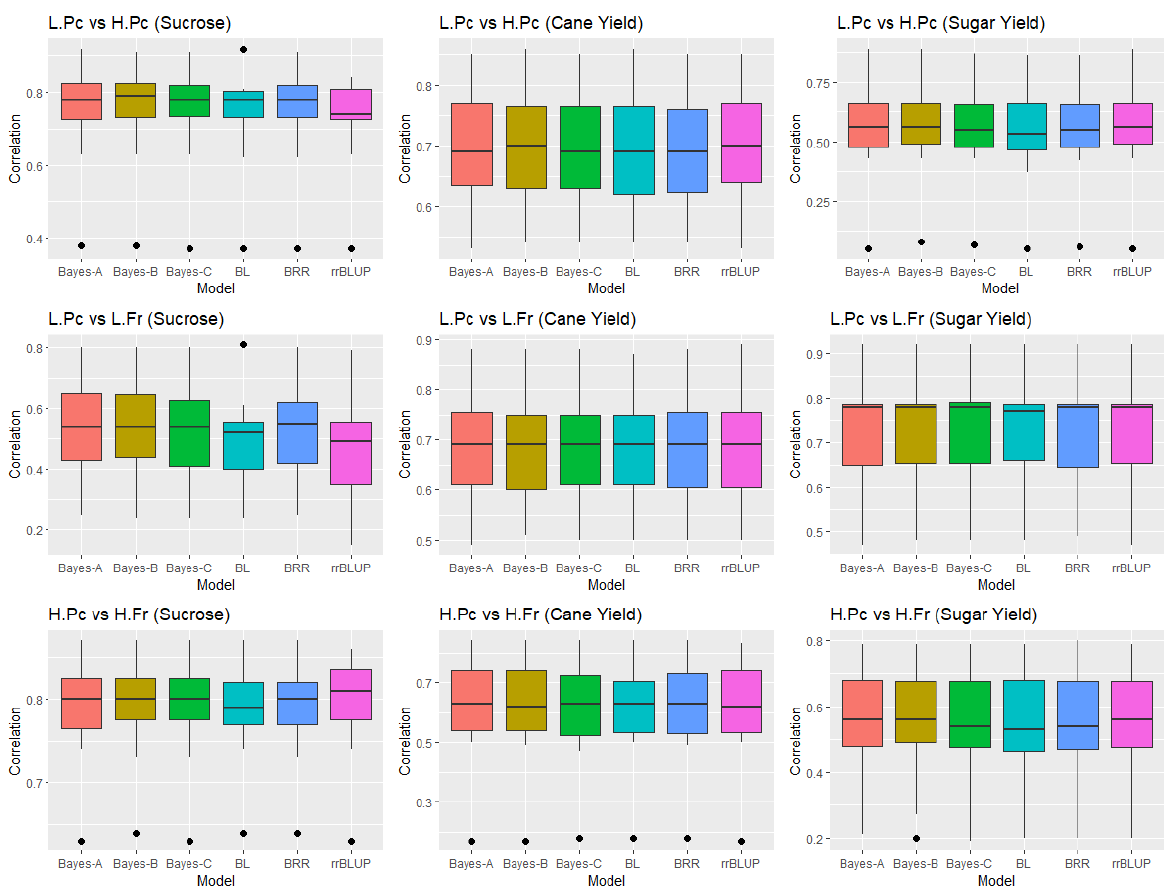
Figure 2. Boxplots showing rank correlations between the actual and predicted phenotype in 10-fold cross-validation. L — Light soil, H — Heavy soil, Pc — Plant cane, R — Ratoon, and Fr — First ratoon.